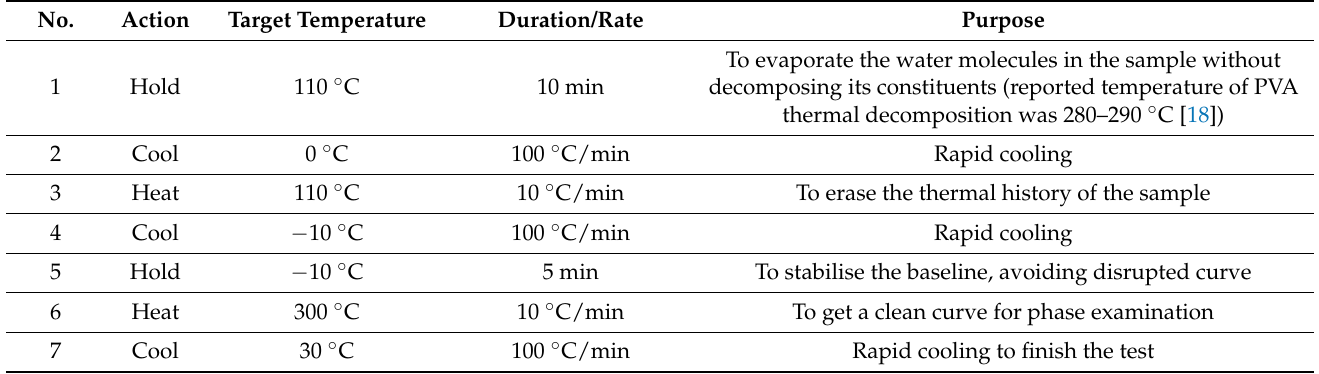
Table 1. Differential scanning calorimetry (DSC) thermal steps and the purpose of each